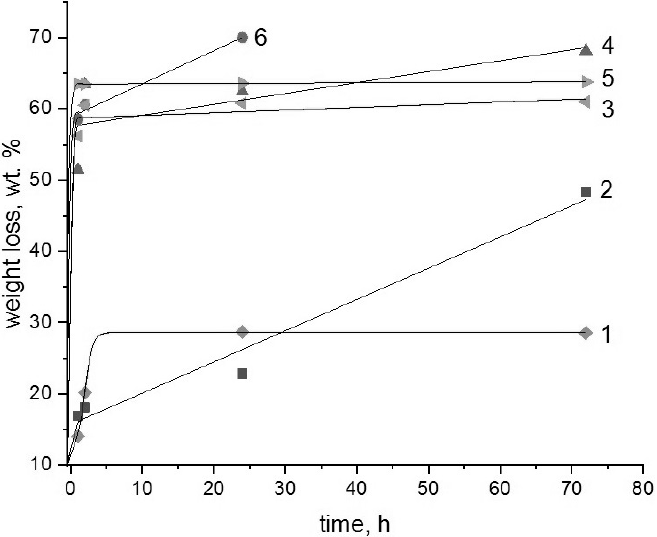
Figure 3. Weight loss kinetics for the binary composite films in the HCl solutions at 70 ° С . The numbers show: Solution concentrations are 0.005 (1), 0.1 (3), 0.2 (5) mol/L for a PHB-chitosan system and 0.005 (2), 0.1 (4), 0.2 (6) mol/L for a PLA-chitosan system.